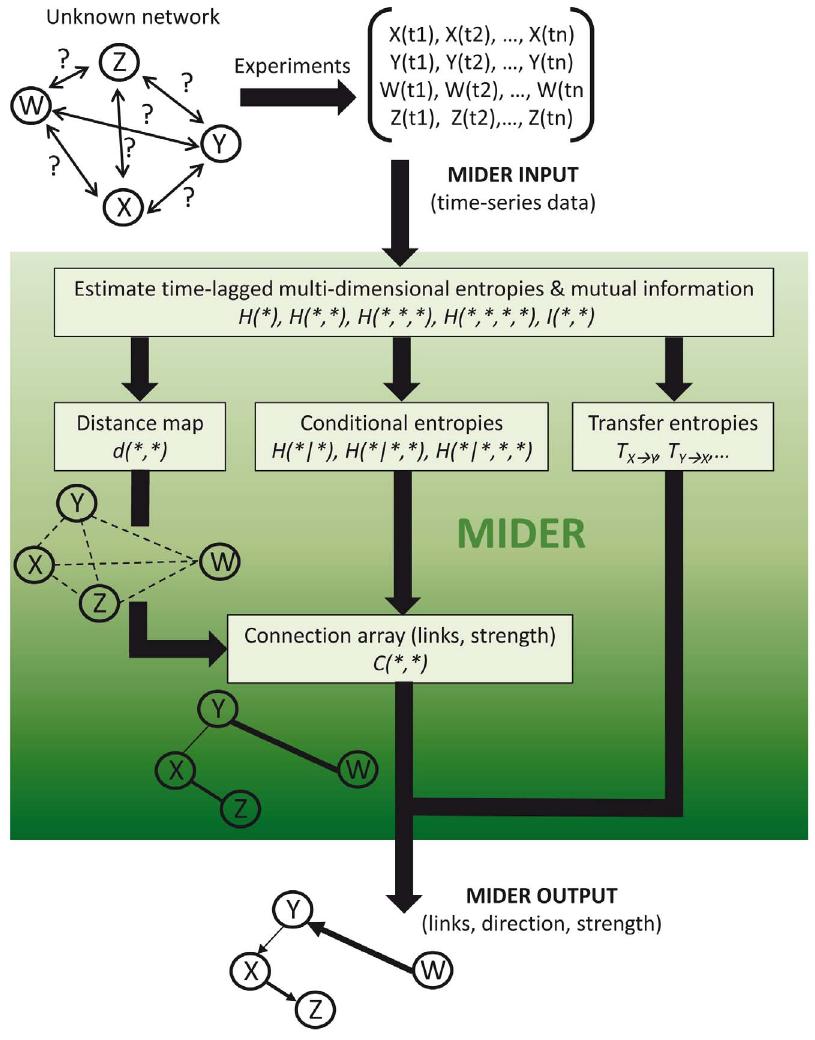
Figure 1. MIDER workflow.